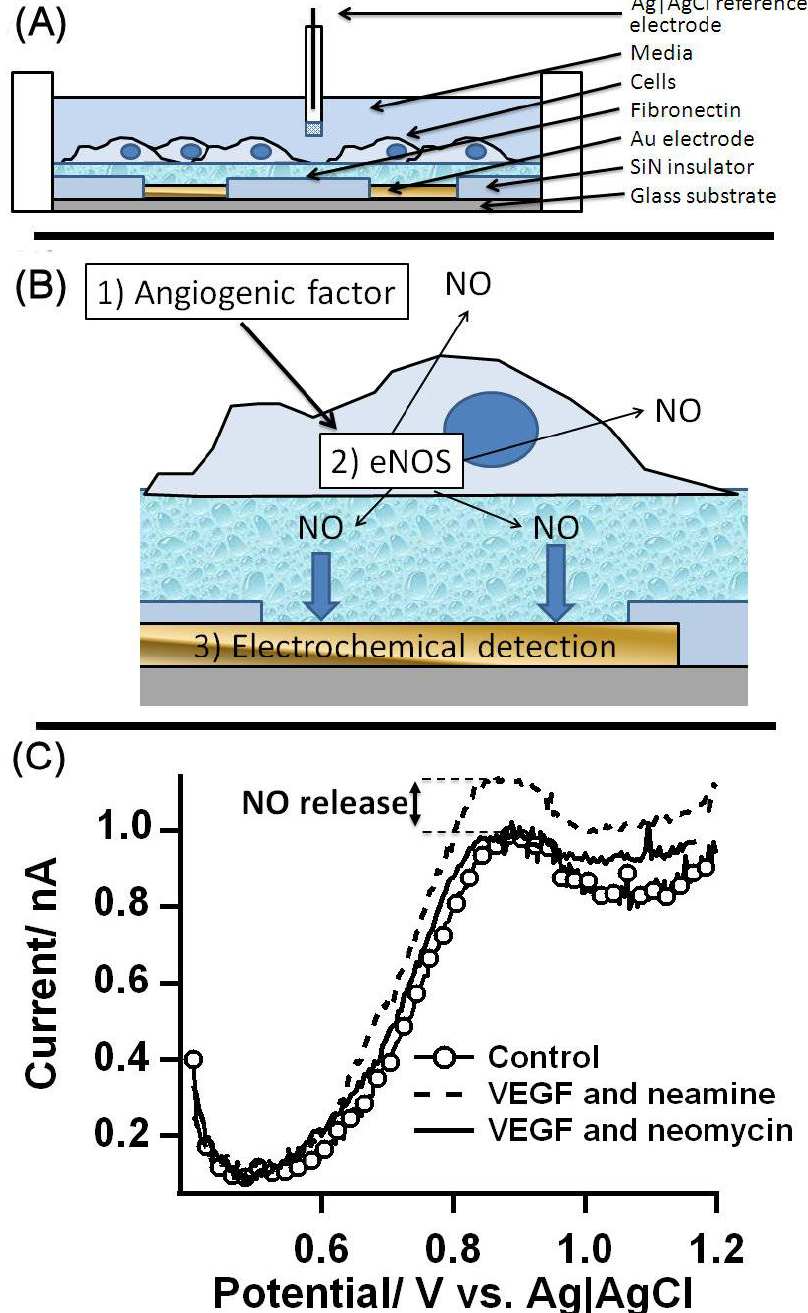
Figure 1. Principle of the electrochemical assay. ( A ) Scheme of the experimental setup, showing the endothelial cells, maintained in their culture media, and grown on a fibronectin sensor array. ( B ) Principle of the measurements, where the angiogenic factor induces NO release, which can, or its oxidation product nitrite, be detected at the underlying electrodes. ( C ) Typical traces obtained for DPV performed in different conditions: control DPV at t = 0 h, t = 2 h after addition of 100 ng.mL − 1 of VEGF with 20 µM neomycin (—) or 20 µM neamine (- - -).